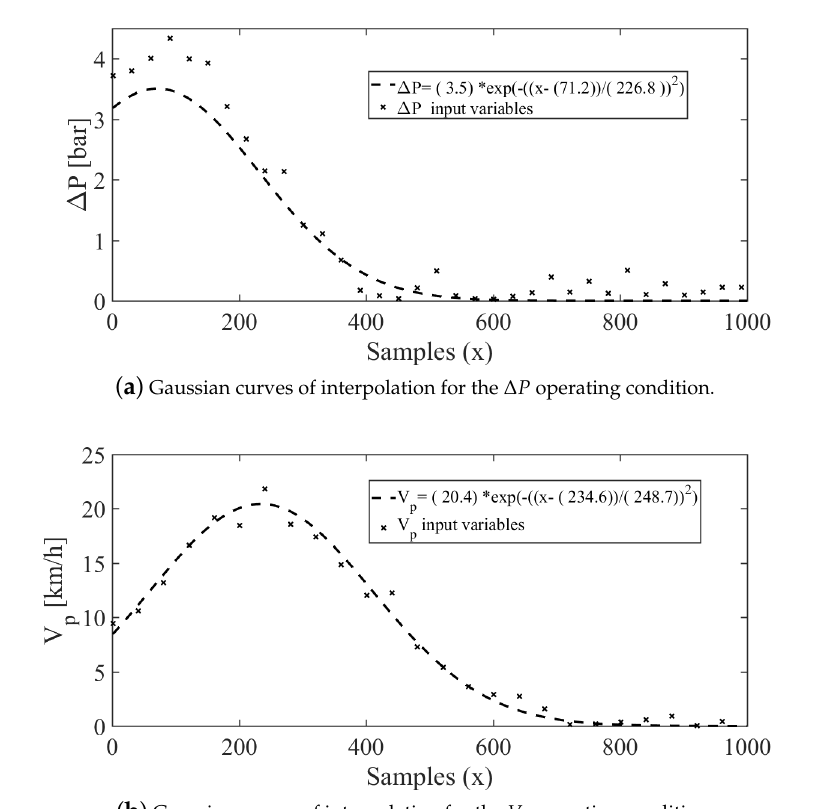
Figure 11. Interpolation results obtained for the operating conditions.